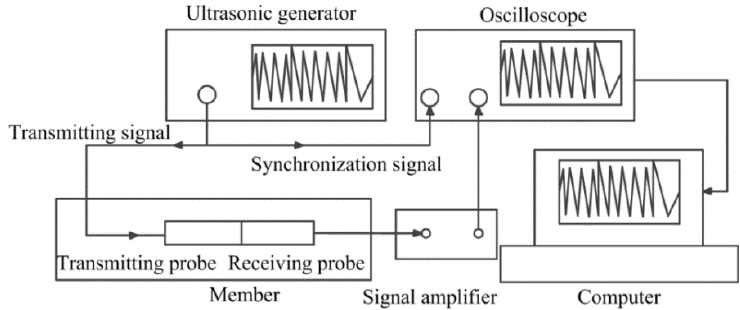
Figure 1. Measurement system schematic diagram.